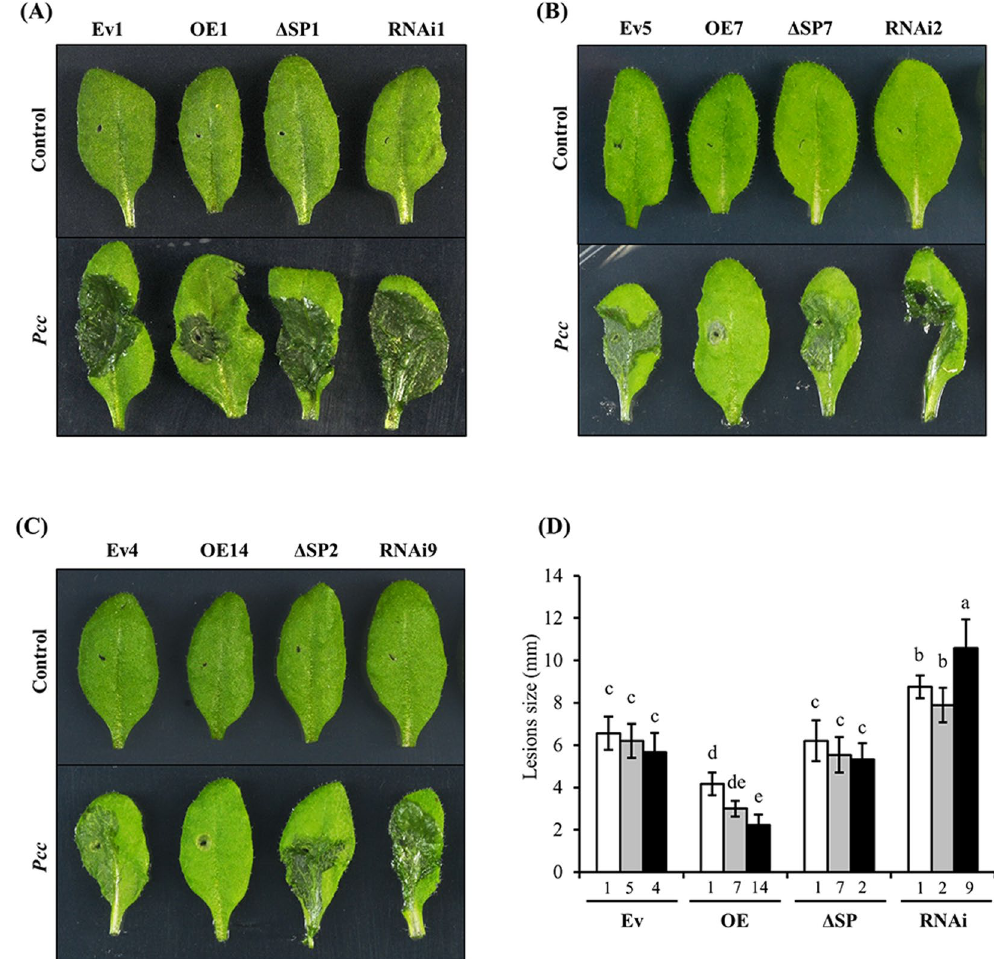
Figure 1. Expression levels of AtPDF1 . 1 correlate with protection against Pcc infection. ( A , B and C ) Transgenic Arabidopsis thaliana plants (Ev: line1, 5, 4; OE: line1, 7, 14; Δ SP: line1, 7, 2; RNAi: line1, 2, 9) were inoculated with Pcc or water (control) and Pcc -mediated symptoms were evaluated at 24 hpi. ( D ) The maximal lesion sizes (diameter; mm) on leaves, denoting bacterial soft rot severity, were determined at 24 hpi. Values are means ± standard errors from ten samples for each line and each infection in a single experiment that was repeated at least three times with similar results. Different letters above each bar indicate significant difference (Fisher’s Least Significant Difference (LSD) LSD post hoc one-way ANOVA, P <